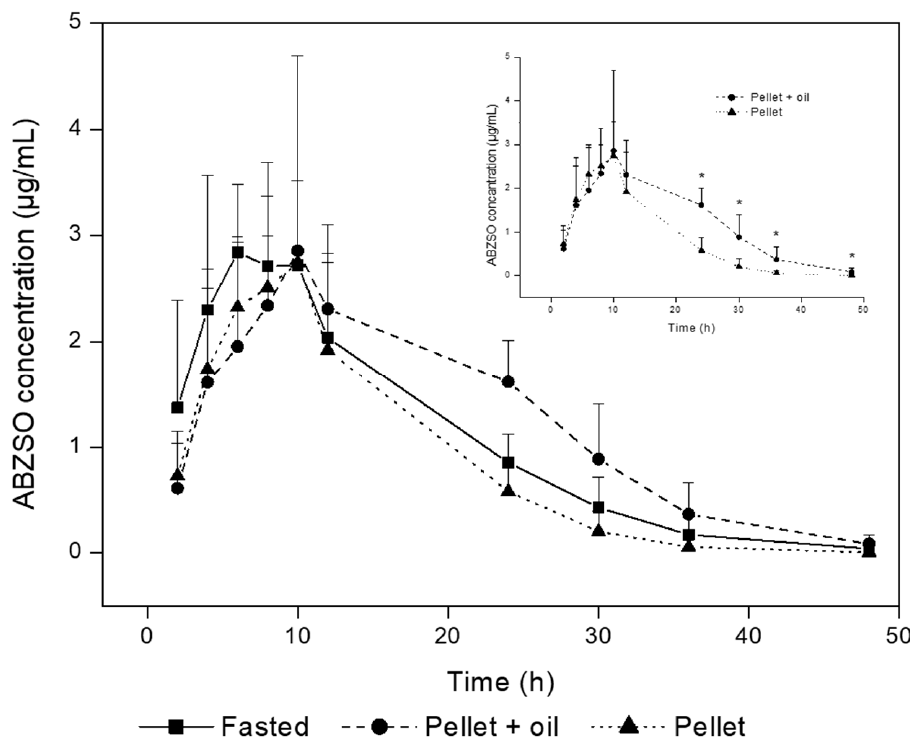
Figure 1. Comparative (mean ± SD) plasma concentration profiles of albendazole sulfoxide (ABZSO) obtained after albendazole suspension administration (10 mg/kg) to pigs either after 8 h fasting (fasting) or fed with a pellet + oil (pellet + oil) or pellet (pellet). The insert shows the comparative (mean ± SD) plasma concentration profiles for the ABZSO between the feeding groups. * Significant differences ( p > 0.05).